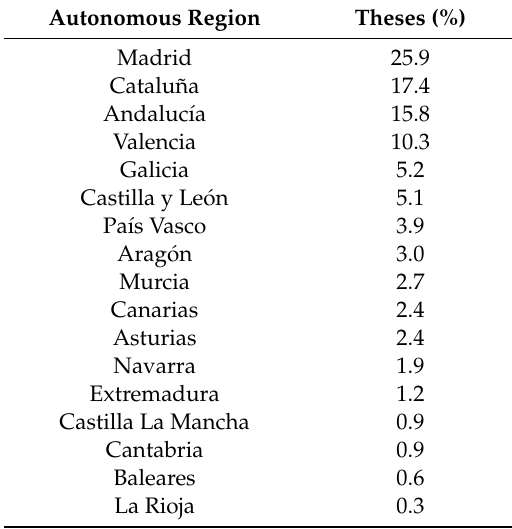
Table 1. Doctoral theses per autonomous